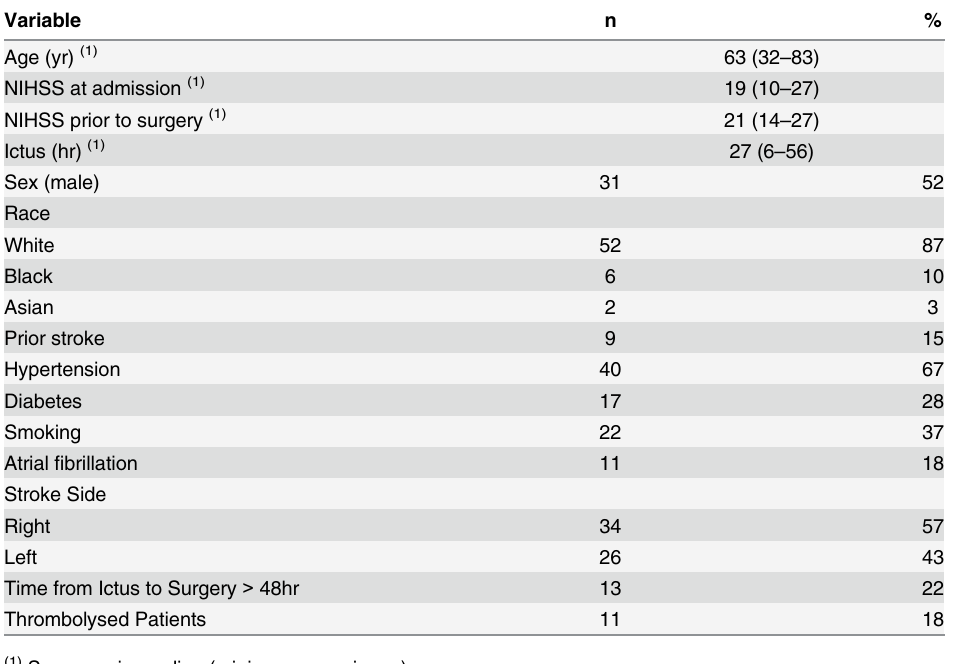
Table 1. Demographic data of overall